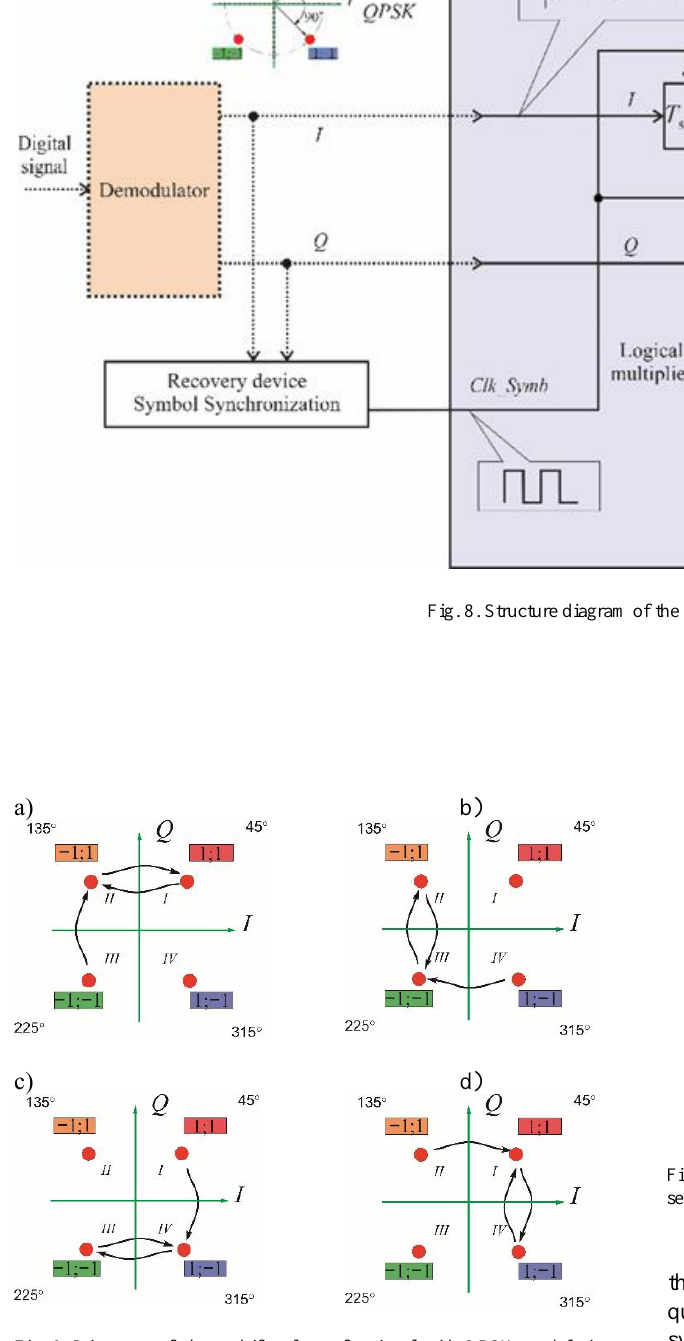
Fig. 9. Diagrams of phase-shift values of a signal with QPSK modulation and phase shifts: a) 0°, b) 90°, c) 180°, d) 270°.